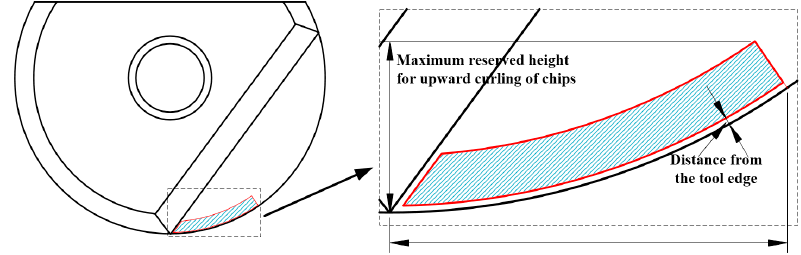
Figure 12. Contact area between the tool and the chip.